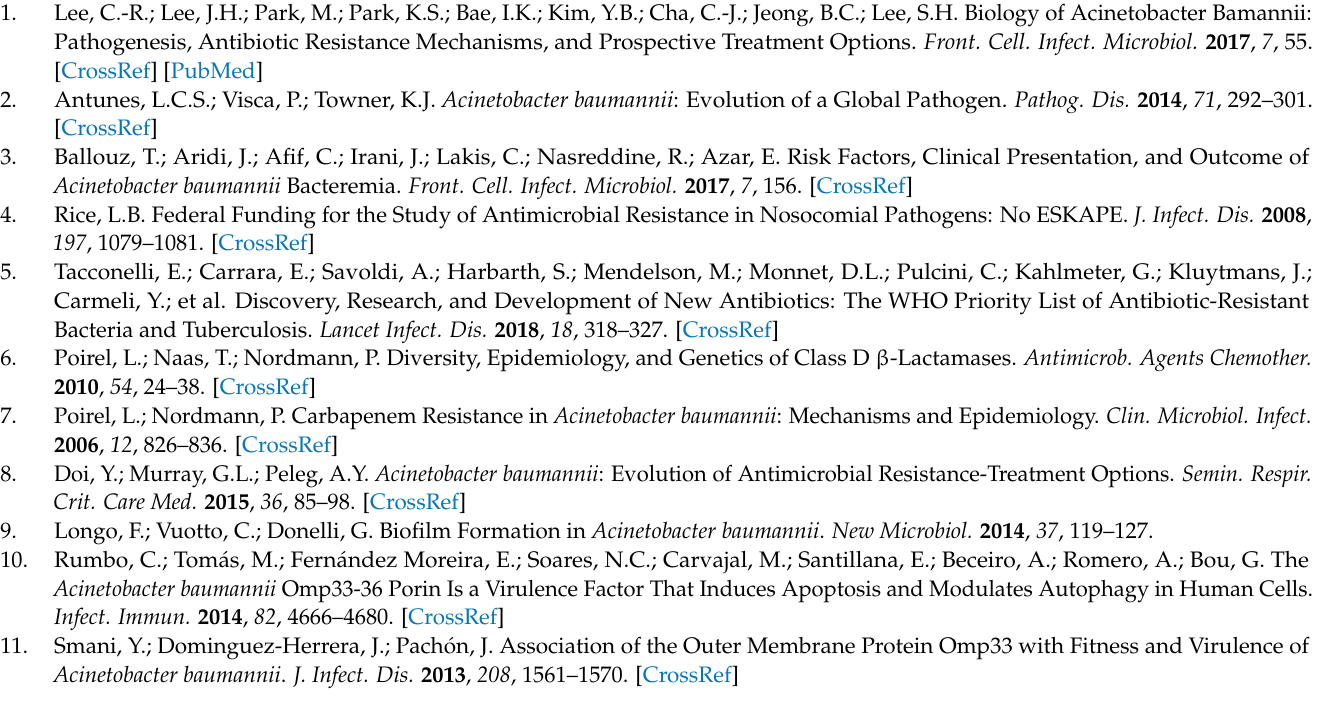
Figure S12: An example of picture showing melting peaks of the real-time PCR product specificity for the omp33-36 gene—CFX OPUS 96 (Bio-Rad, Hercules, CA, USA); Figure S13: Picture of amplification curves showing results of real-time PCR for the bla OXA-40 gene detection—LightCycler 480 II (Roche, Basel, Switzerland); Figure S14: An example of melting peaks picture showing specificity of the real-time PCR product for the bla OXA-40 gene—LightCycler 480 II (Roche, Basel, Switzerland); Figure S15: Picture of amplification curves showing results of real-time PCR for the bla OXA-23 gene detection— LightCycler 480 II (Roche, Basel, Switzerland); Figure S16: An example of picture showing melting peaks of the real-time PCR product specificity for the bla OXA-23 gene—LightCycler 480 II (Roche, Basel,